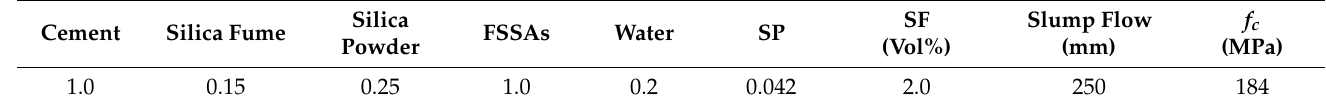
Table 3. Composition of smart